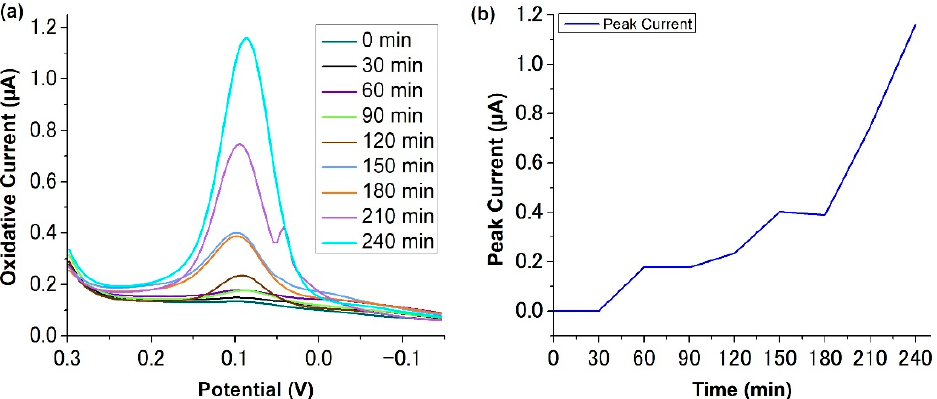
Figure 2. ( a ) Square wave voltammograms of 5 mM PAPP (pH 7) at increasing sonication times on a GSPE and ( b ) peak current vs. sonication time. An increase in peak current occurs with increasing sonication time.